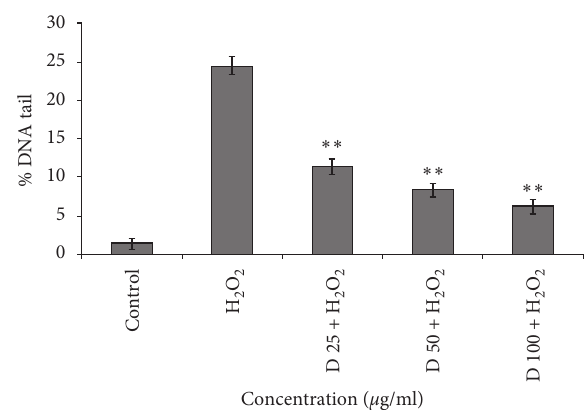
Figure 2: Effect of fraction on lymphocyte DNA damage induced by 50 μ M H 2 O 2 . Human lymphocytes were incubated for 15min at 4 ° C with a combination of 50 μ MH 2 O 2 with different concentra- tions of fractions (25, 50, and 100 μ